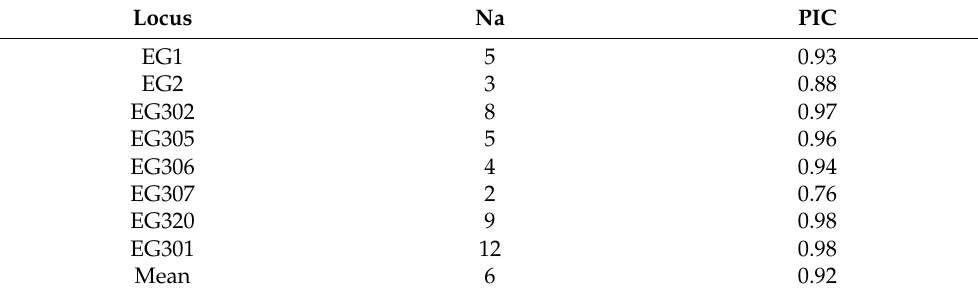
Table 4. Estimates parameters of allele numbers and polymorphic information content (PIC) in the 8 pairs of Simple Sequence Repeat markers analyzed in Echinochloa crus-galli . Locus Na